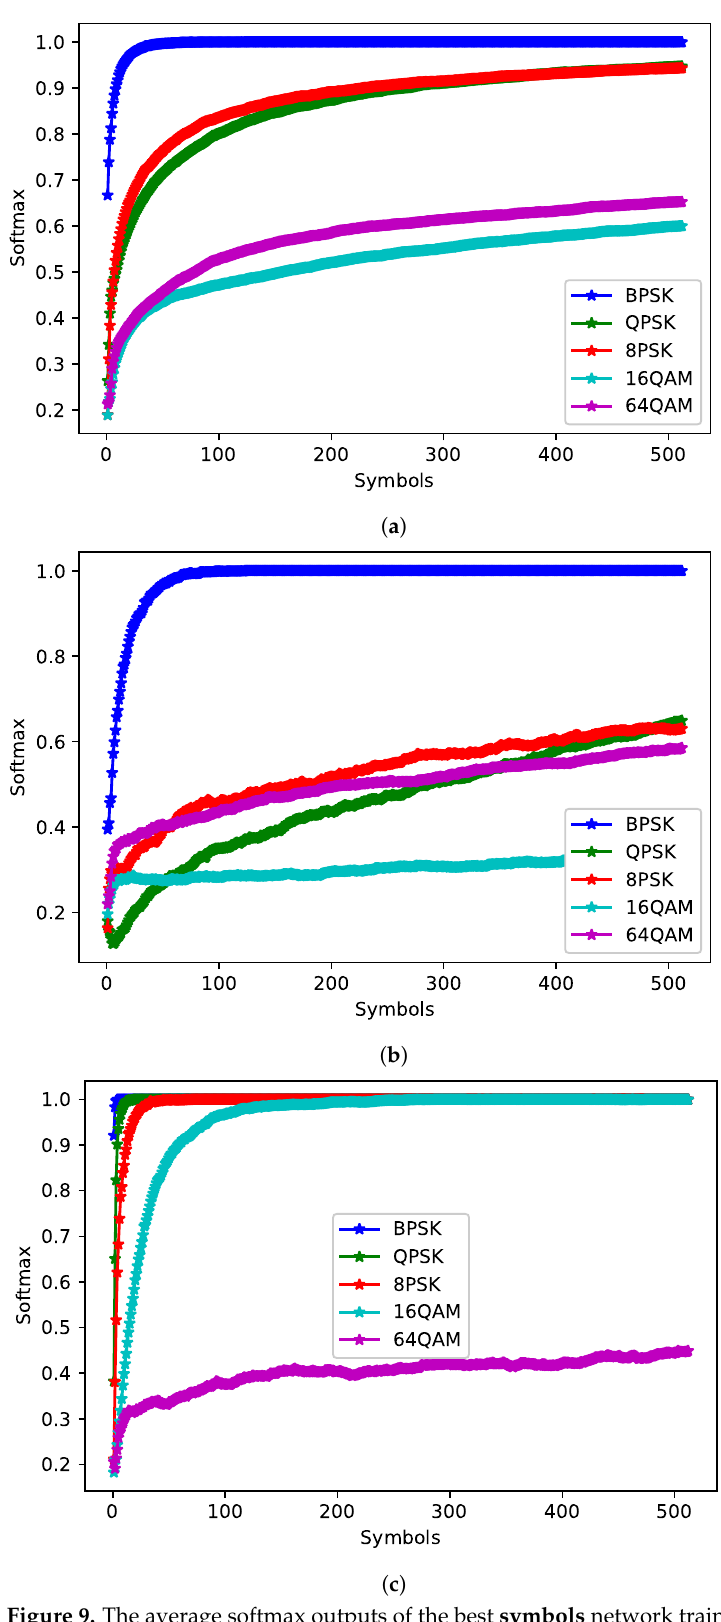
Figure 9. The average softmax outputs of the best symbols network trained on 512 symbols ( a ) aver- aged from 0 to 10 dB ( b ) at 0 dB and ( c ) at 10